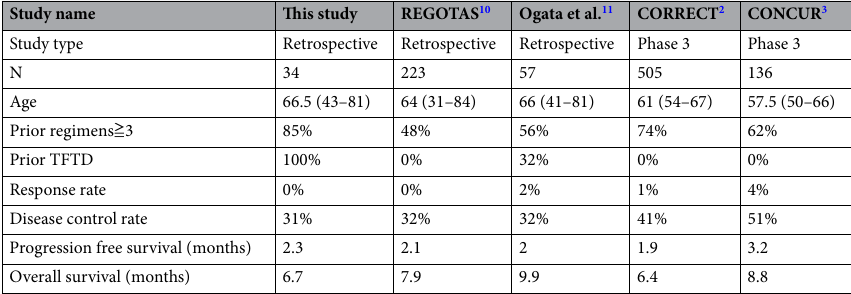
Table 3. Efficacy of regorafenib as a salvage line chemotherapy for colorectal cancer. TFTD trifluridine/